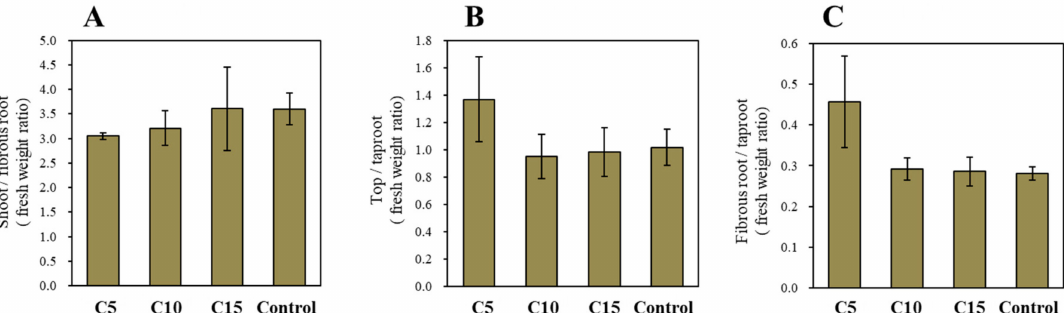
Figure 6. E ff ect of partial taproot excision on the ratios of plant organs of carrots 28 days after partial taproot excision. ( A ) (Shoot fresh weight) / (fibrous root fresh weight). ( B ) (Shoot fresh weight) / (taproot fresh weight). ( C ) (Fibrous root fresh weight) / (taproot fresh